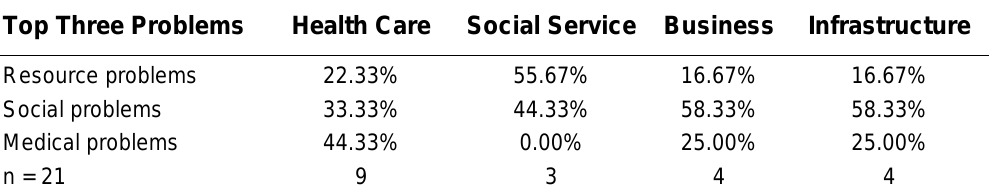
Problem Type by Job